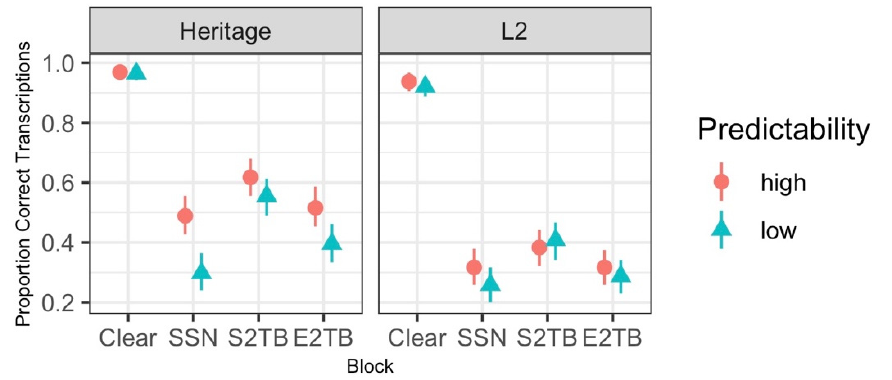
Figure 1. Raw accuracy data from the speech-in-noise transcription task. (SSN = speech-shaped noise, S2TB = Spanish two-talker babble, E2TB = English two-talker babble).